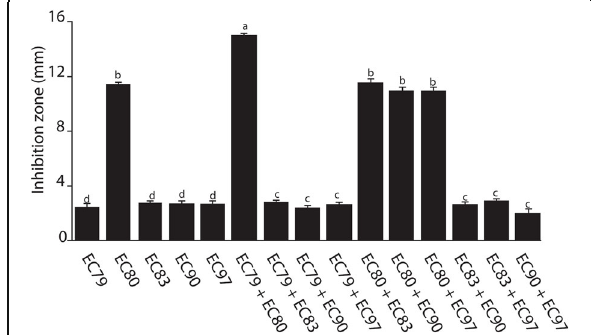
Fig. 1 Effect of co-culturing of five endophytic bacterial strains on fungal growth of Alternaria alternata . Fungal growth data are given for PDA agar plates inoculated with single bacterial strains and mixtures of these strains. Error bars denote standard deviations (three replicates). Different letters indicate significant differences ( P < 0.05) between